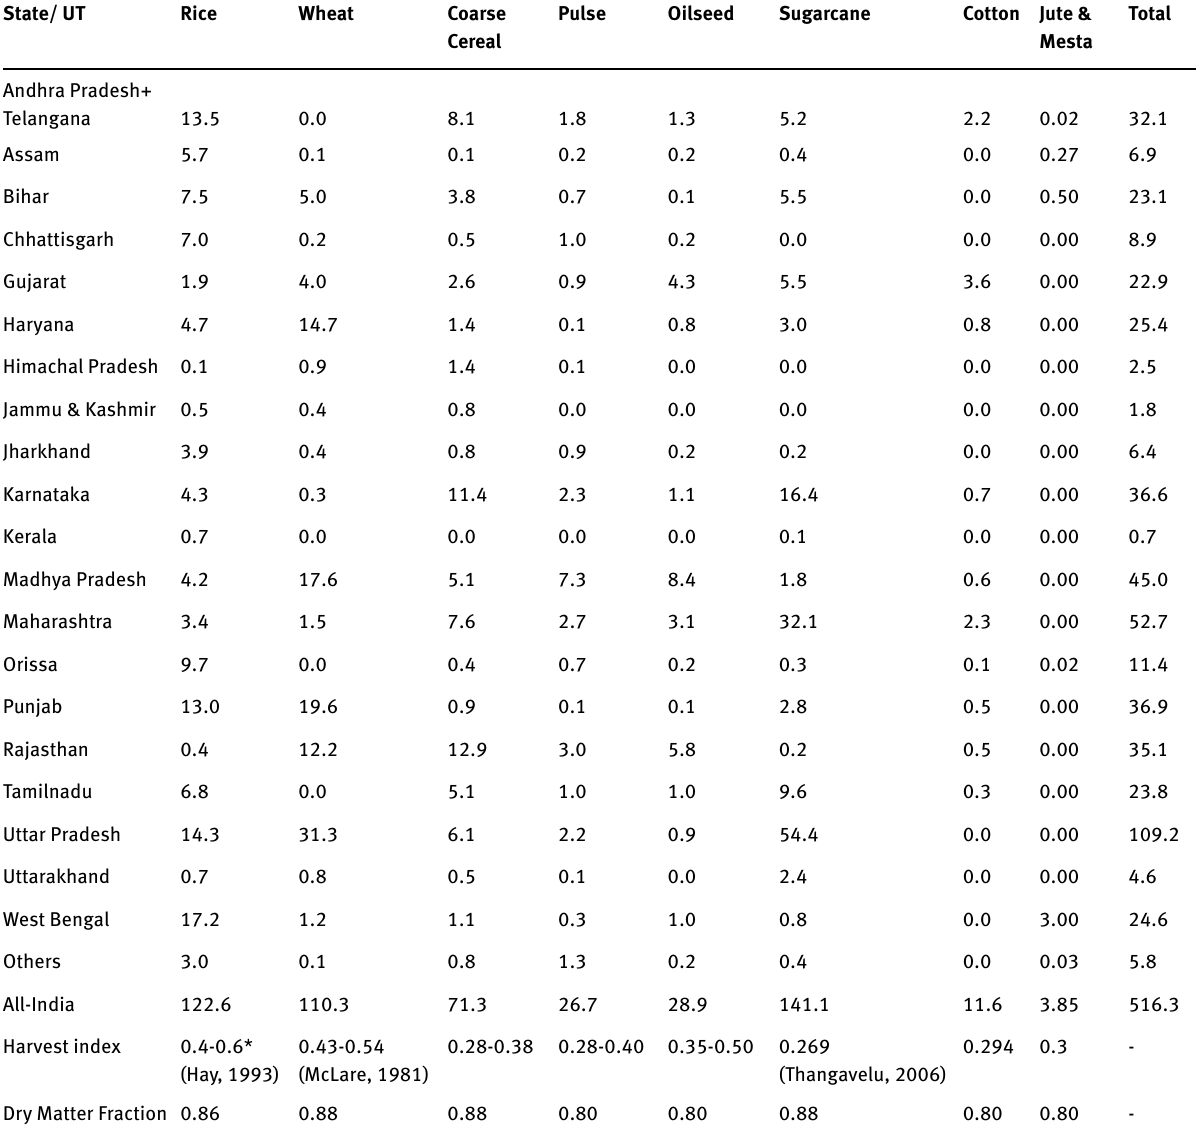
Table 1: Total crop residue generation (tonnes) in different states of India during 2014-15 State/ UT Rice Wheat Coarse